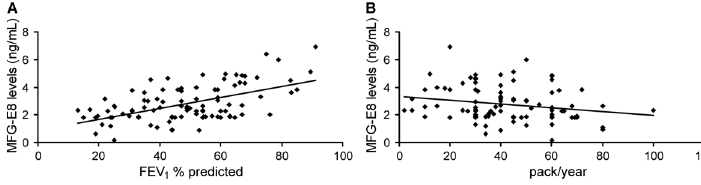
Figure 2. Correlation analysis between milk fat globule epidermal growth factor 8 (MFG-E8),